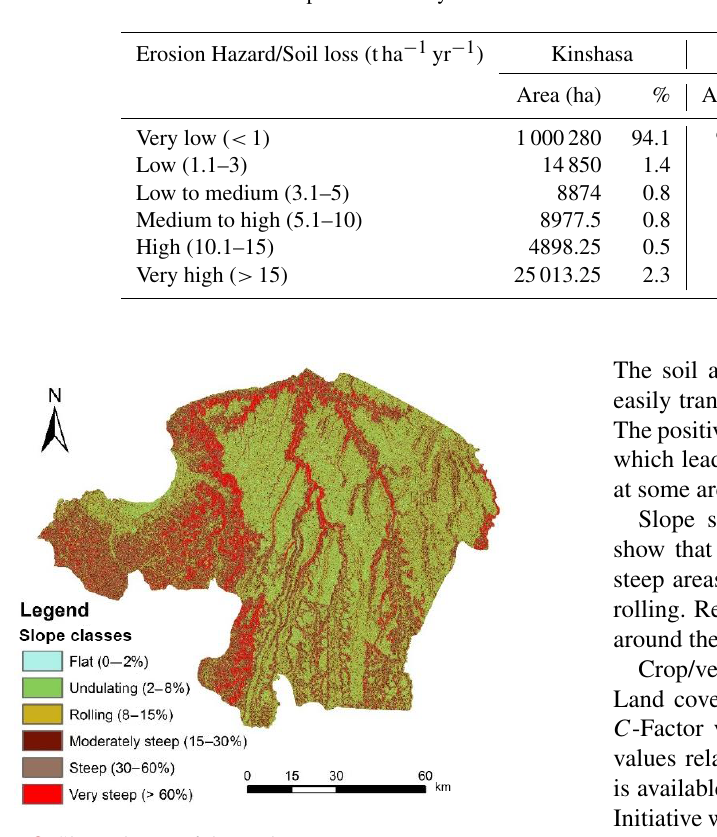
Table 2. Erosion Hazard and soil loss potential of city of Kinshasa.